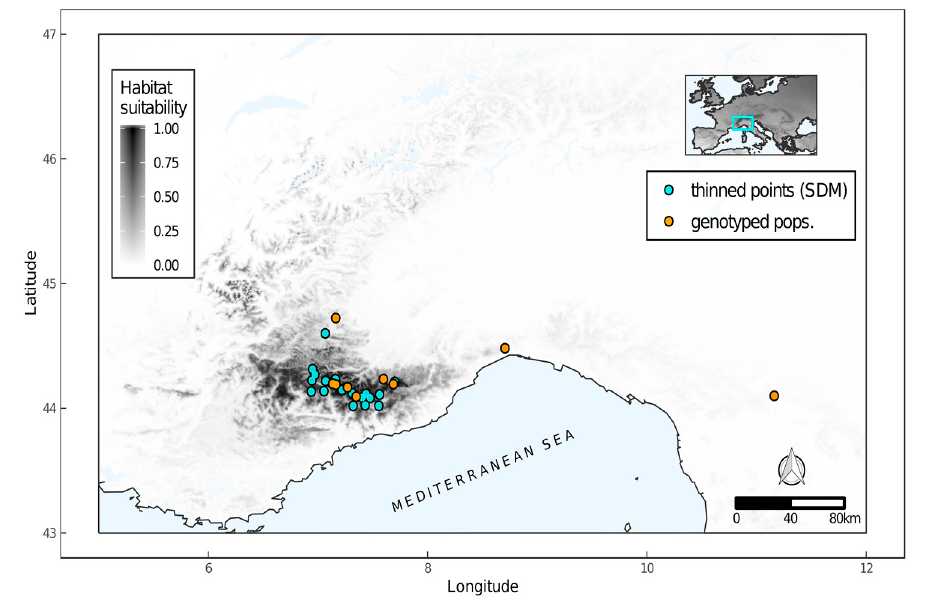
Figure 4. Predicted habitat suitability for Tephroseris balbisiana based on ensemble of the results of species distribution models. Gradient of grey gives habitat suitability, with darker areas indicating greater suitability.